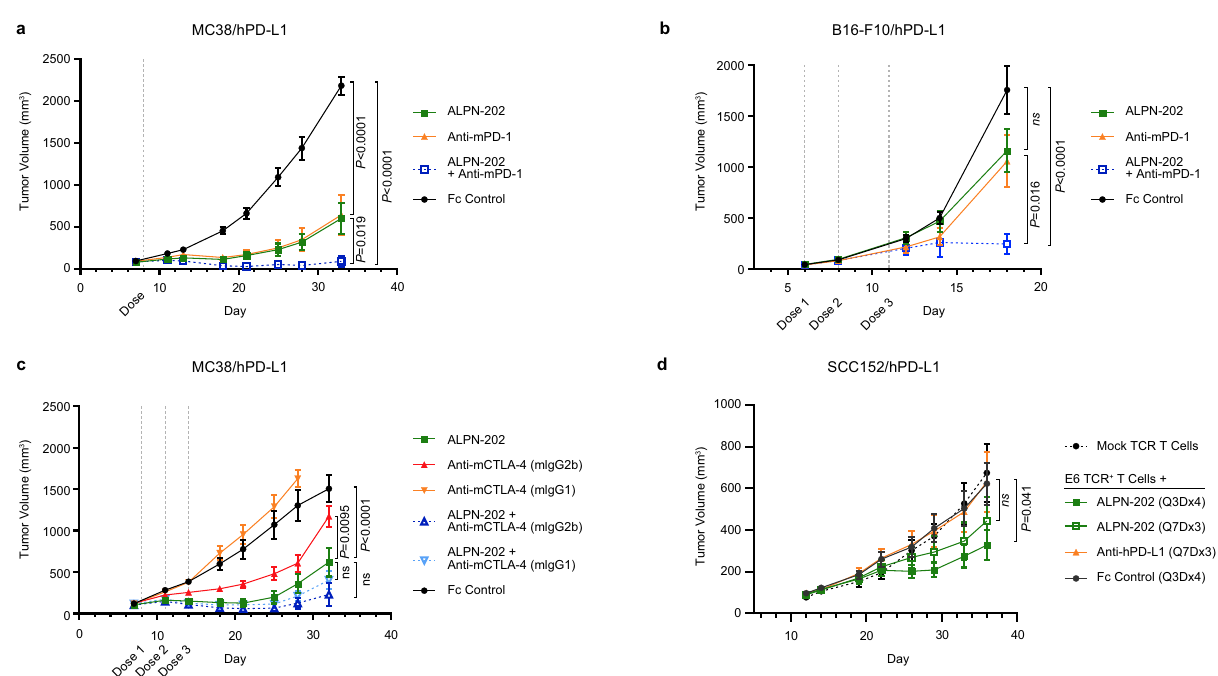
Fig. 7 ALPN-202 combines with anti-PD1 and anti-CTLA-4 antibodies and is active in a humanized tumor model. a , b Tumor growth curves for ( a ) hPD- L1-expressing MC38 tumors ( n = 10 mice/group) or ( b ) B16-F10 tumors ( n = 9 mice/group) treated with ALPN-202 (green line), anti-mPD-1 (orange line), a combination of ALPN-202 and anti-mPD-1 (blue), or an isotype control (black). c MC38/hPD-L1 tumors ( n = 9 mice/group) treated with ALPN- 202 (green), anti-mCTLA-4 formatted with either mIgG2b Fc (red) or inert Fc (orange), or combinations of ALPN-202 with each mCTLA-4 antibody (dark blue, light blue respectively). d Tumor growth curves ( n = 9 mice/group) from NSG mice implanted with human E6 TCR + transgenic T cells as well as human SCC152/hPD-L1 tumor cells treated with ALPN-202 either every three days for four doses (dark green; Q3Dx4) or once every seven days for three doses (light green; Q7Dx3), anti-hPD-L1 (durvalumab, orange) or Fc control (black). NSG NOD-scid IL2R γ null ; E6 TCR, T cell receptor speci fi c for E6 peptide. All experiments were repeated at least two times and data shown are representative. Statistical signi fi cance was determined by repeated- measures two-way ANOVA for treatment effects. For all graphs, means ± SEM are shown. Source data are provided as a Source Data fi